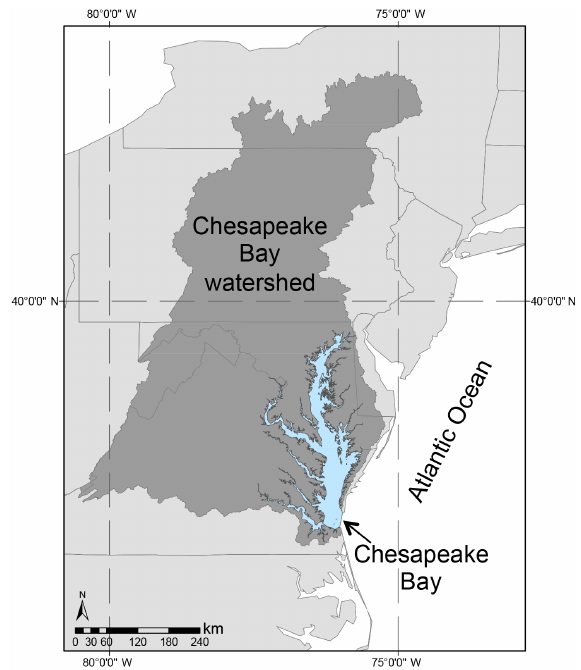
Figure 1. Map of the Chesapeake Bay and its